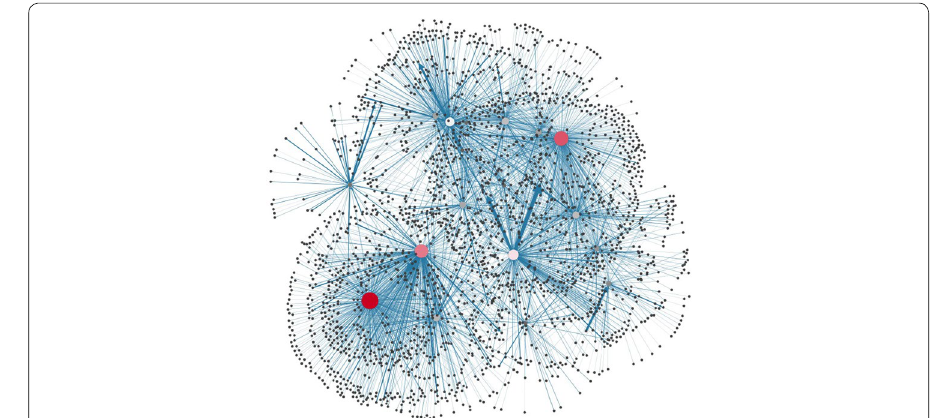
Fig. 2 Visualization for a sample of the Telecom social network